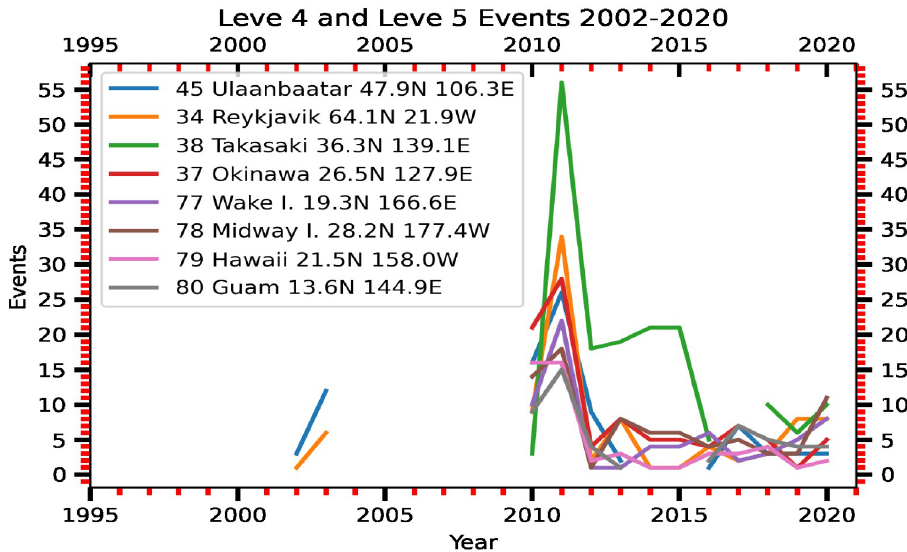
Fig 16. Annual total of the level 4 and leve 5 events during the period 1945–2019. The number in front of the station name indicates the radionuclide station index according to the